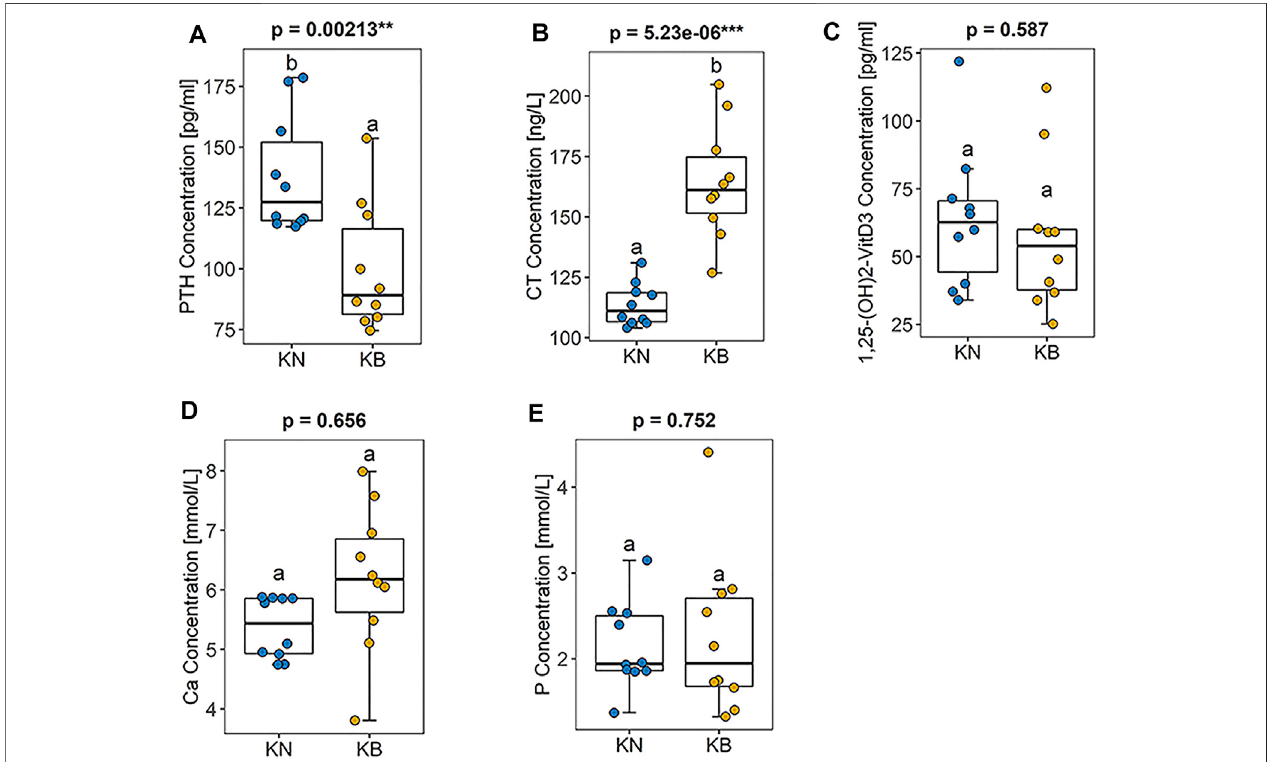
FIGURE 3 | Boxplots of blood biochemical indexes in KN and KB chicken groups (A) PTH concentration (B) CT concentration (C) 1,25-dihydroxyvitamin D3 concentration (D) Ca concentration, and (E) P concentration.